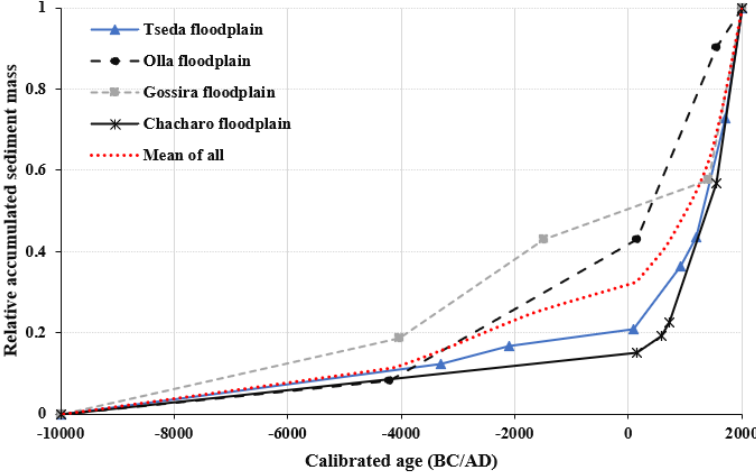
Figure 16. Age and average relative accumulated sediment mass for the different dated corings in floodplain deposits in the Chencha catchments (broken line in red color is the mean value for the entire catchment) .